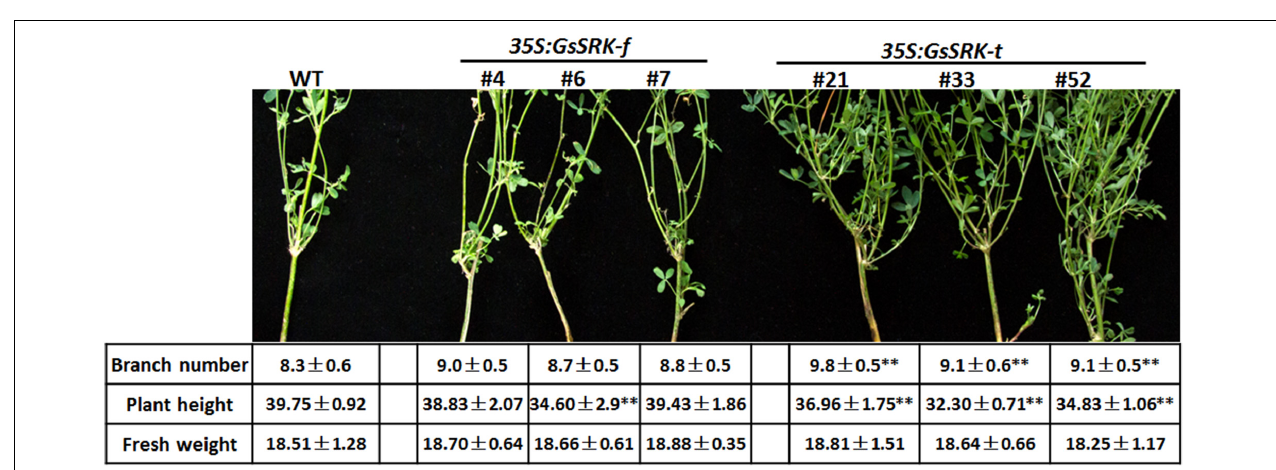
FIGURE 3 | Overexpression of GsSRK-t but not GsSRK-f in alfalfa results in morphological changes. Pictures show the branching of the WT, GsSRK-f and GsSRK-t transgenic alfalfa. Detailed information of the branch numbers, plant height, and fresh weight are shown in the table. Data are shown as means ± SE ( n ≥